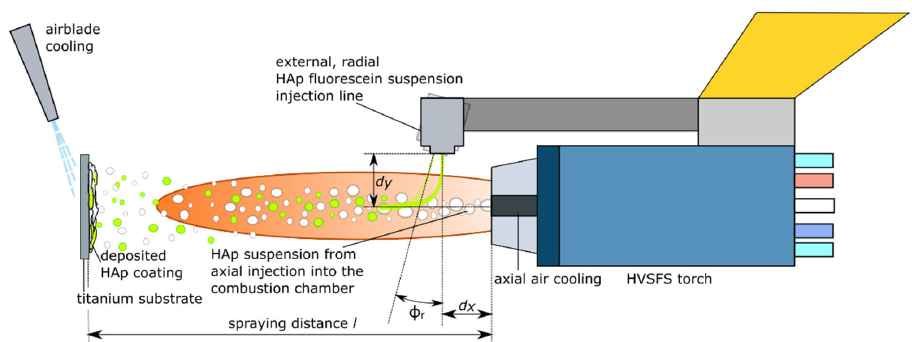
Figure 1. Schematic setup of the HVSFS torch used in the coating process.